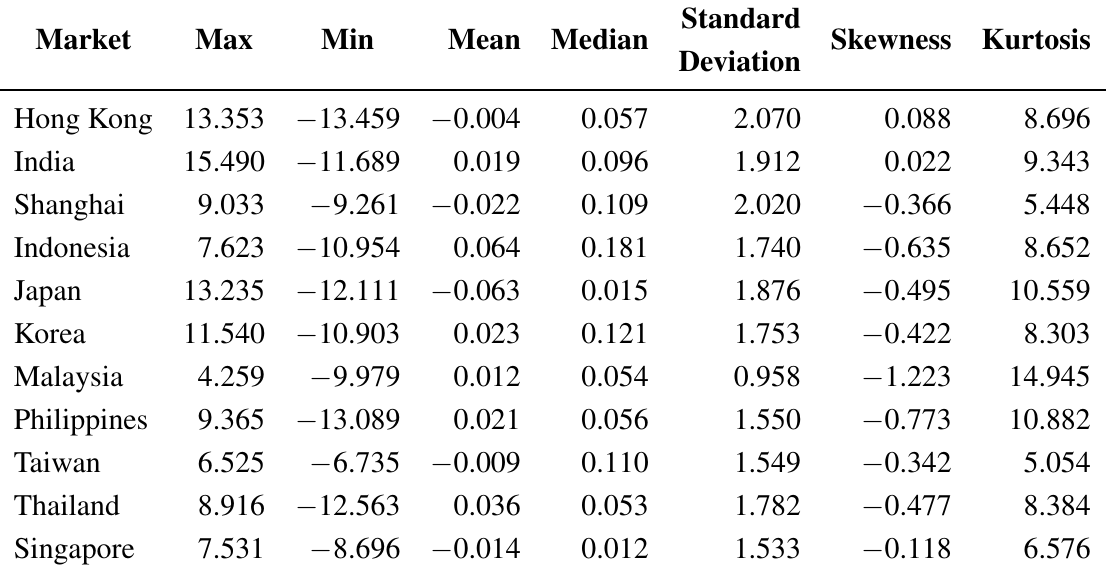
Table 4. Univariate statistics for the daily index returns.